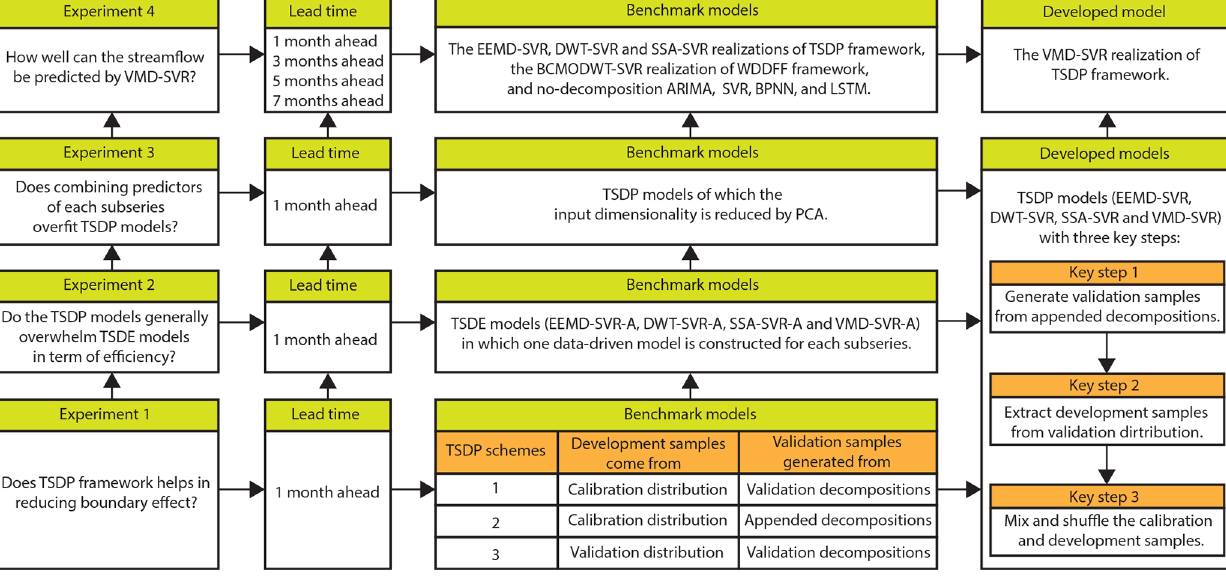
Figure 7. A block diagram of the comparative experimental setups.